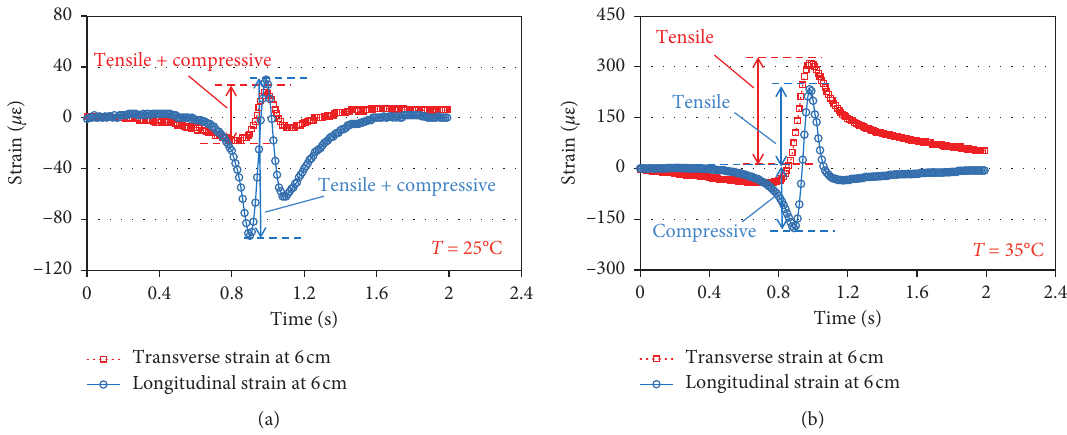
Figure 6: Typical strain pulses at 6cm of asphalt layer under (a) intermediate and (b) high temperatures.